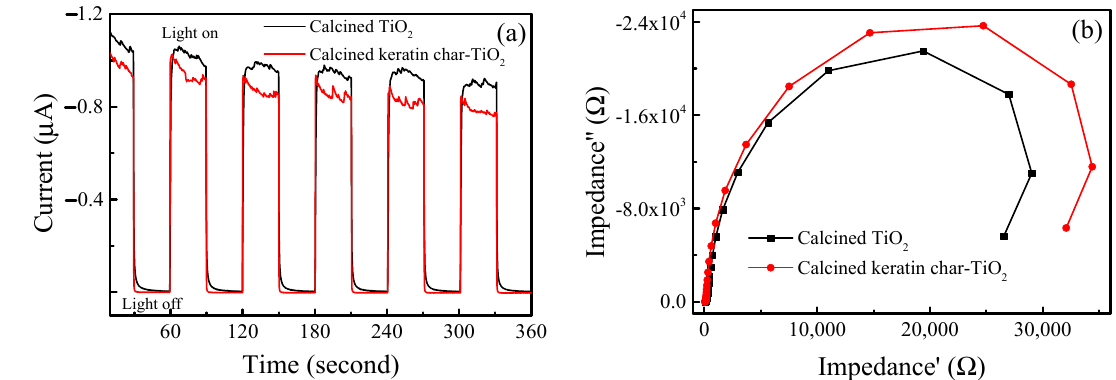
Figure 8. The ( a ) photocurrent-time curves and ( b ) EIS Nyquist plots of the calcined TiO 2 film and calcined keratin char-TiO 2 composite film.